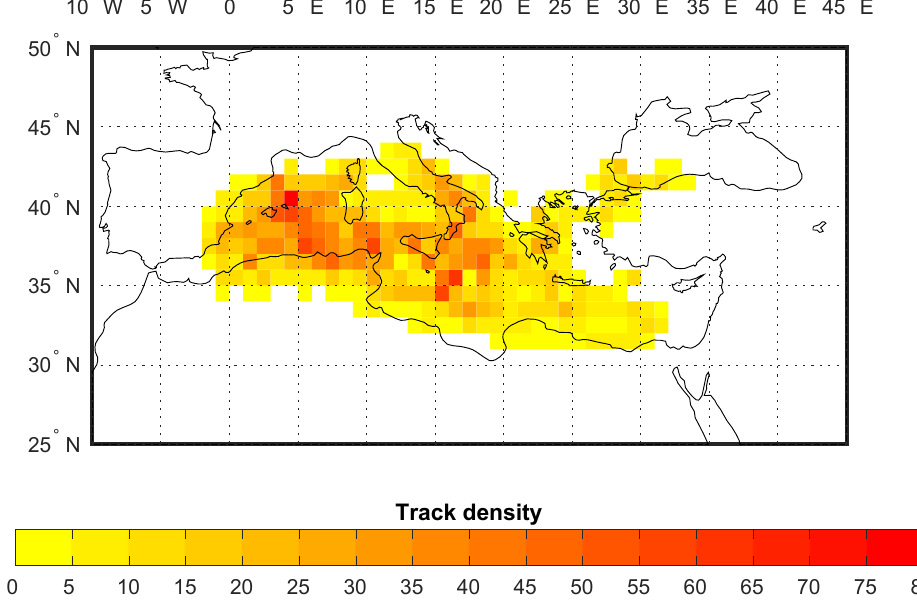
Figure 4. Track density of simulated Medicanes in the 1948–2010 period (COSMO-CLM, 10 km grid resolution, forcing: NCEP; [4]).